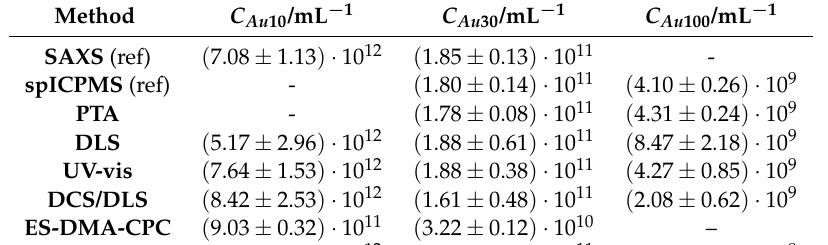
Table 2. Number concentration of the gold suspensions. The tag “(ref)” denotes reference methods.